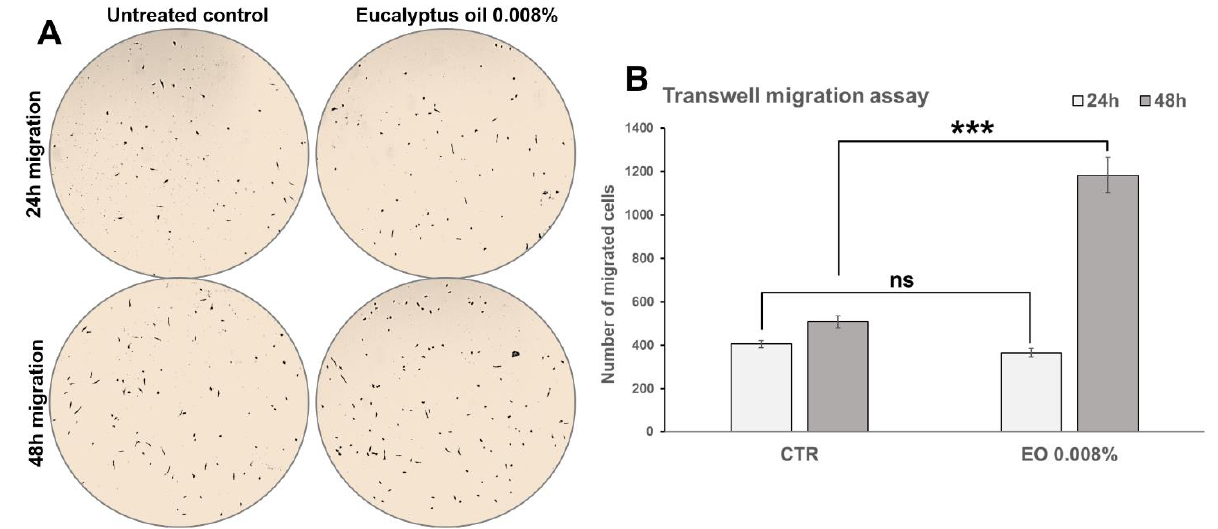
Figure 8. Effect of Eucalyptus oil on macrophage motility by Transwell migration assay. ( A ) Repre- sentative images of Giemsa-stained cells recovered at the bottom of the inserts after 24 h and 48 h of incubation in absence (untreated control) and in presence of 0.008% EO. ( B ) Bar graph reporting the quantification of number of cells recovered at the bottom of the inserts after 24 and 48 h from the seeding of untreated and in EO-stimulated MDMs. The assay was performed on samples in triplicate ( n = 3), and results are reported as mean values ± S.D. Significance vs. CTR (two-tailed Student’s t -test): *** p < 0.001; ns: not significant.